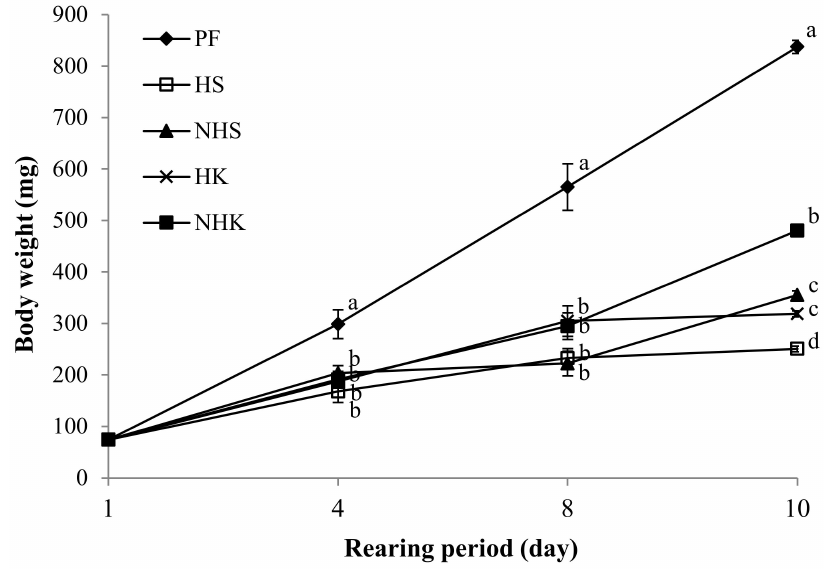
Figure 3. Final body weight of Pacific bluefin tuna juveniles fed different diets during the rearing period. Different superscript letters indicate significant difference among the dietary groups (Tukey’s test, p < 0.05; 1st day, n = 50; 4th and 8th day, n = 10; 10th day, n = 120). HS, heated squid meal; NHS, non-heated squid meal; HK, heated krill meal; NHK, non-heated krill meal; PF, prey fish; Spangled emperor larvae, Lethrinus nebulosus .